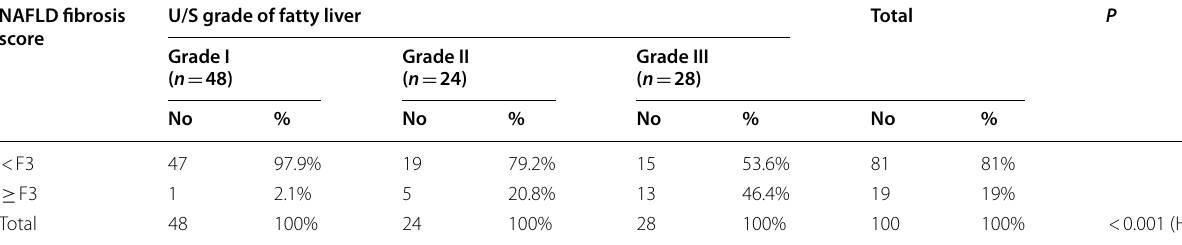
Table 10 Relation between U/S grade of fatty liver and NAFLD fibrosis score results NAFLD fibrosis U/S grade of fatty liver score